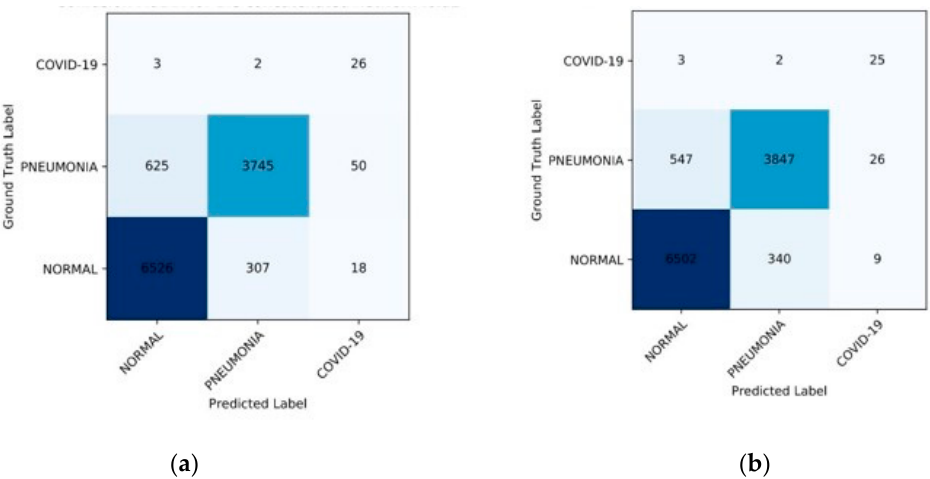
Figure 9. Confusion Matrix with different train–test splits: ( a ) Train–test split 80–20% and ( b ) Train– test split 70–30%.